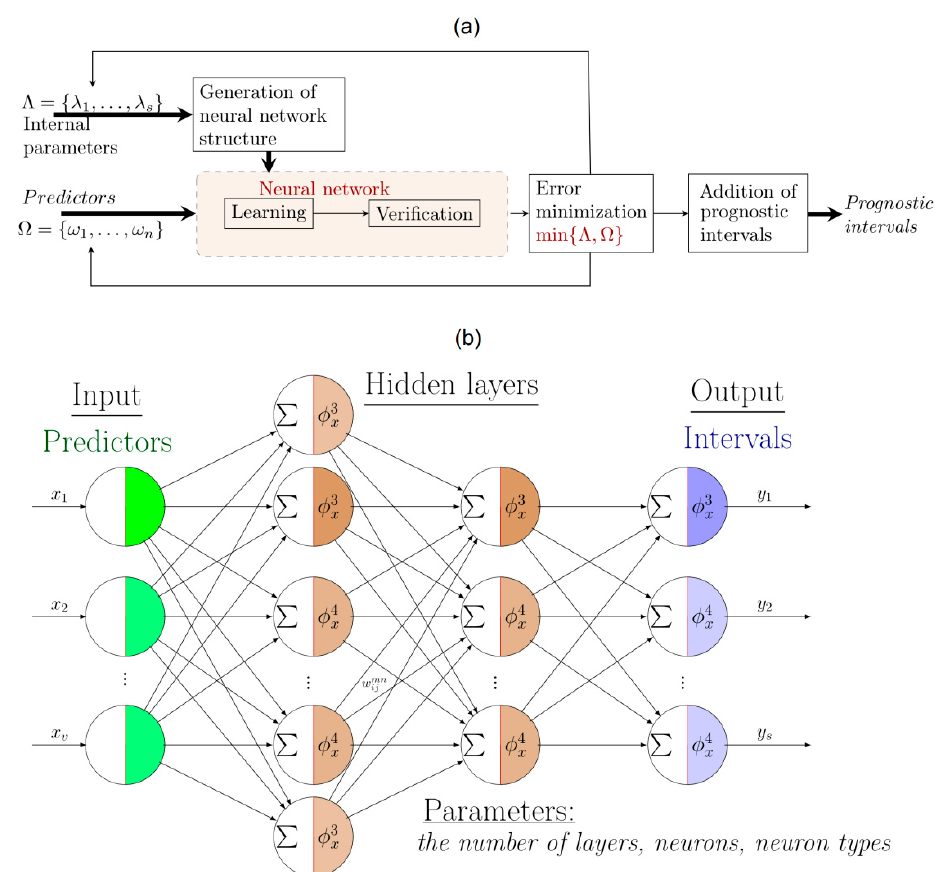
Figure 1. The structure of a multivariate neural network: ( a ) a network adjustment scheme for generating predictive interval estimates; ( b ) the core of the neural network.